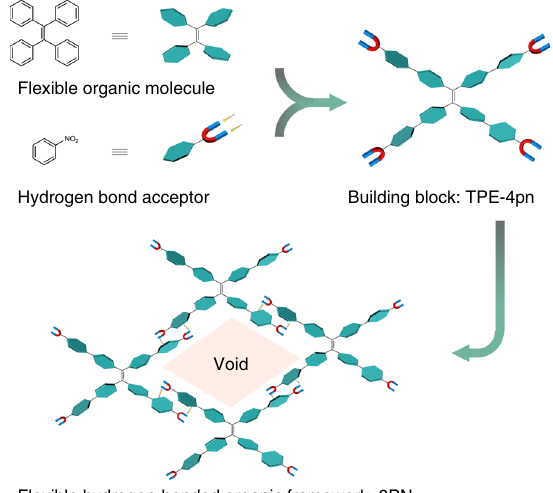
Fig. 1 The design strategy for 8PN. The fl exible framework is constructed from TPE-4pn through hydrogen-bonding